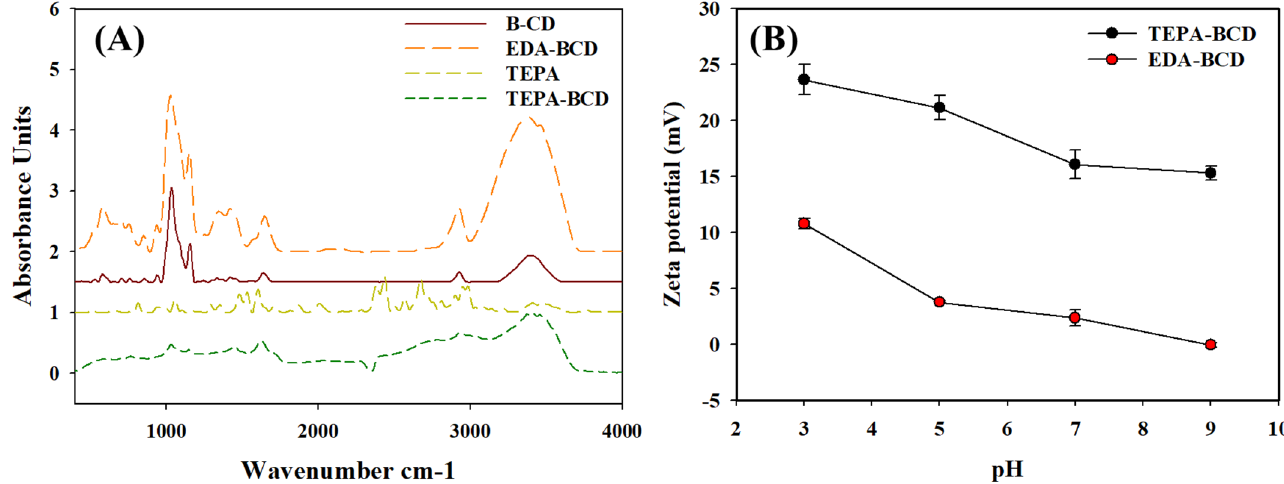
Figure 1. ( A ) FTIR spectra of BCD, EDA-BCD, TEPA, and TEPA-BCD nanoparticles. ( B ) Zeta potential on surfaces of TEPA-BCD and EDA-BCD in different pH solutions. Error bars represent the standard deviation (n = 3).